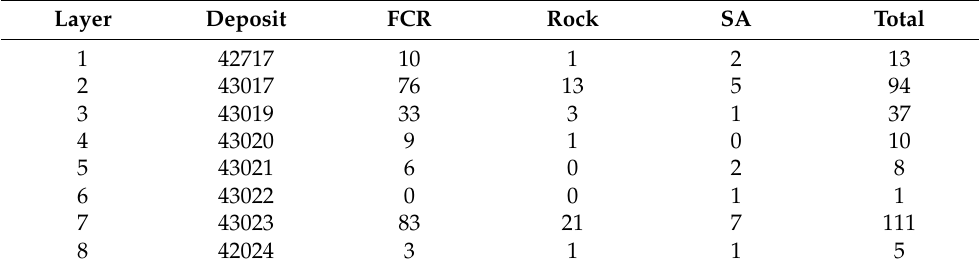
Table 1. Artefacts excavated from EA231 by deposit, with deposit numbers and their relative associations. FCR = fire-cracked rock; SA = stone artefact.